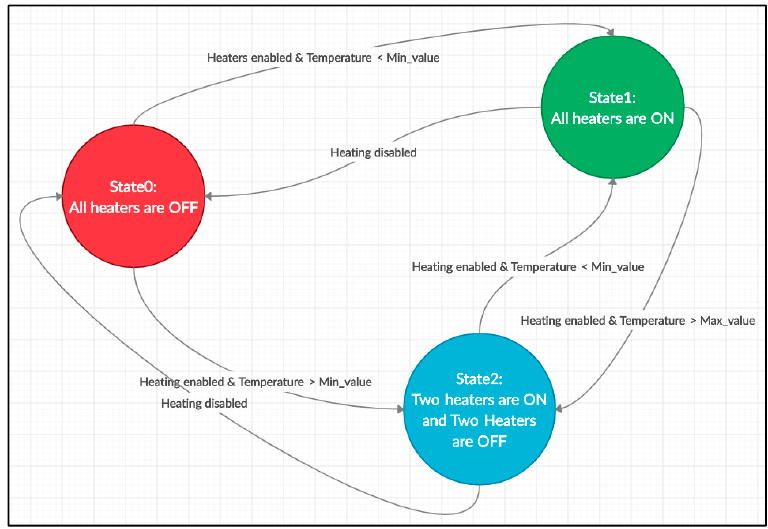
Figure 12. Finite State Machine (FSM) State diagram that controls Linux Laboratory heater.